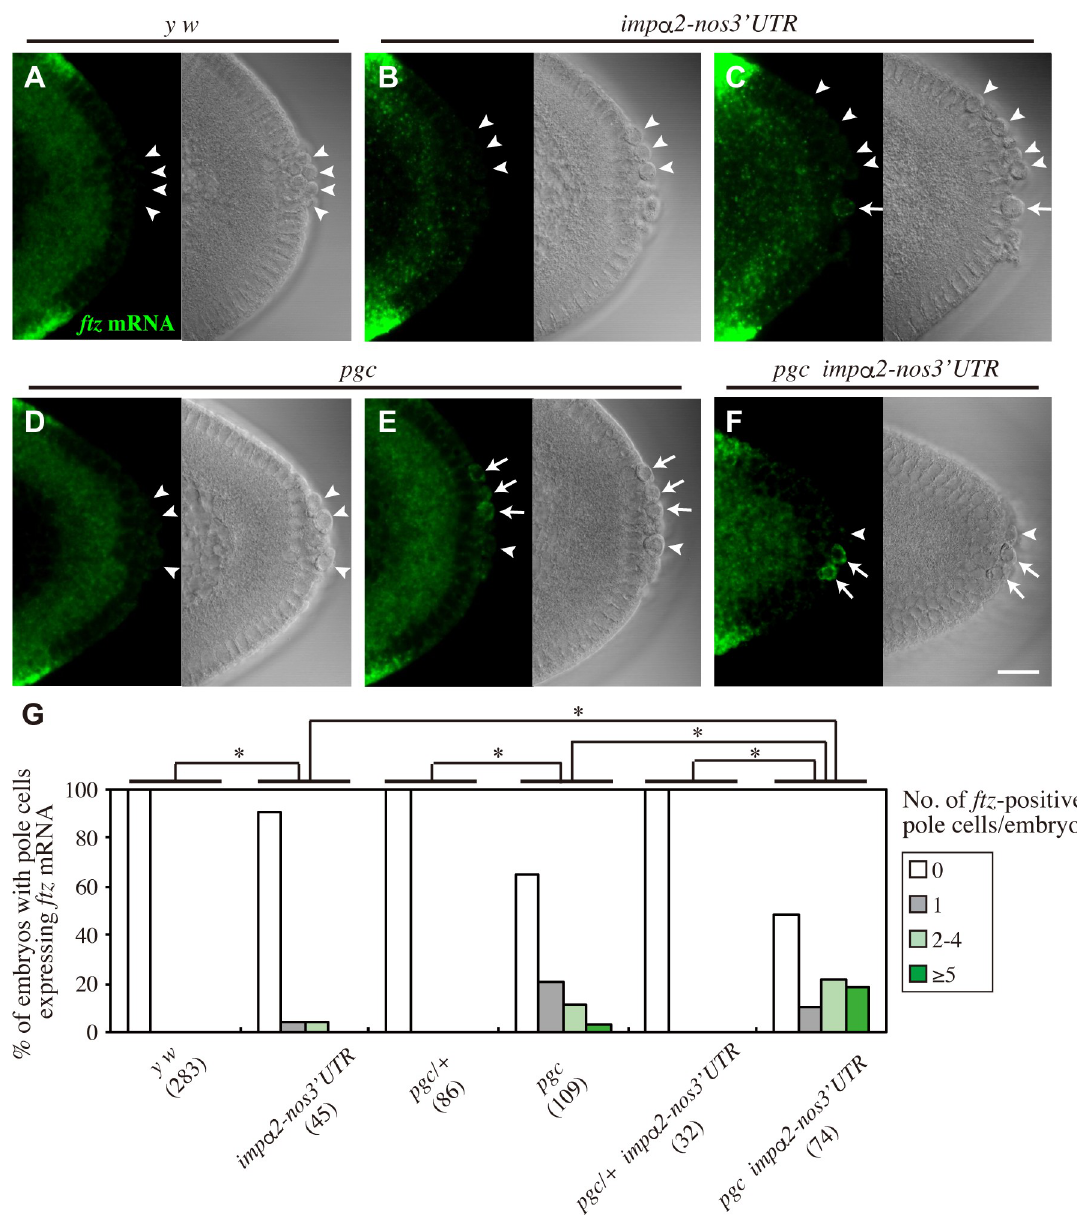
Fig 4. Mis-expression of Imp α 2 causes ectopic expression of ftz in pole cells lacking Pgc. ( A–F ) ftz mRNA expression in pole cells of embryos derived from y w ( A ) and imp α 2-nos3´UTR females ( B and C ), and from pgc/pgc females with ( pgc imp α 2-nos3´UTR ) ( F ) or without two copies of imp α 2-nos3´UTR ( pgc ) ( D and E ). Stage-5 embryos were stained for ftz mRNA (green, left). DIC images (right) are also shown. Arrows or arrowheads point to pole cells with or without ftz signal, respectively. Although ftz signal was occasionally detected in pole cells of imp α 2-nos3´UTR embryos ( C ) and pgc embryos ( E ), the signal intensity in these pole cells was usually less than that in pole cells of pgc imp α 2-nos3´UTR embryos ( F ). Scale bar, 20 μ m. ( G ) Expression of ftz mRNA was examined in pole cells of embryos from late stage 4 to stage 5. Embryos were derived from y w , imp α 2-nos3´UTR , pgc/+ , pgc , pgc/+ ; imp α 2-nos3´UTR/ imp α 2-nos3´UTR ( pgc/+ imp α 2-nos3´UTR ), and pgc imp α 2-nos3´UTR females mated with y w males. Percentages of embryos containing 0 (white), 1 (gray), 2–4 (pale green), or � 5 (green) pole cells with ftz mRNA signal are shown. The numbers of embryos examined are shown in parentheses. Significance was calculated using Fisher’s exact test ( � : P <